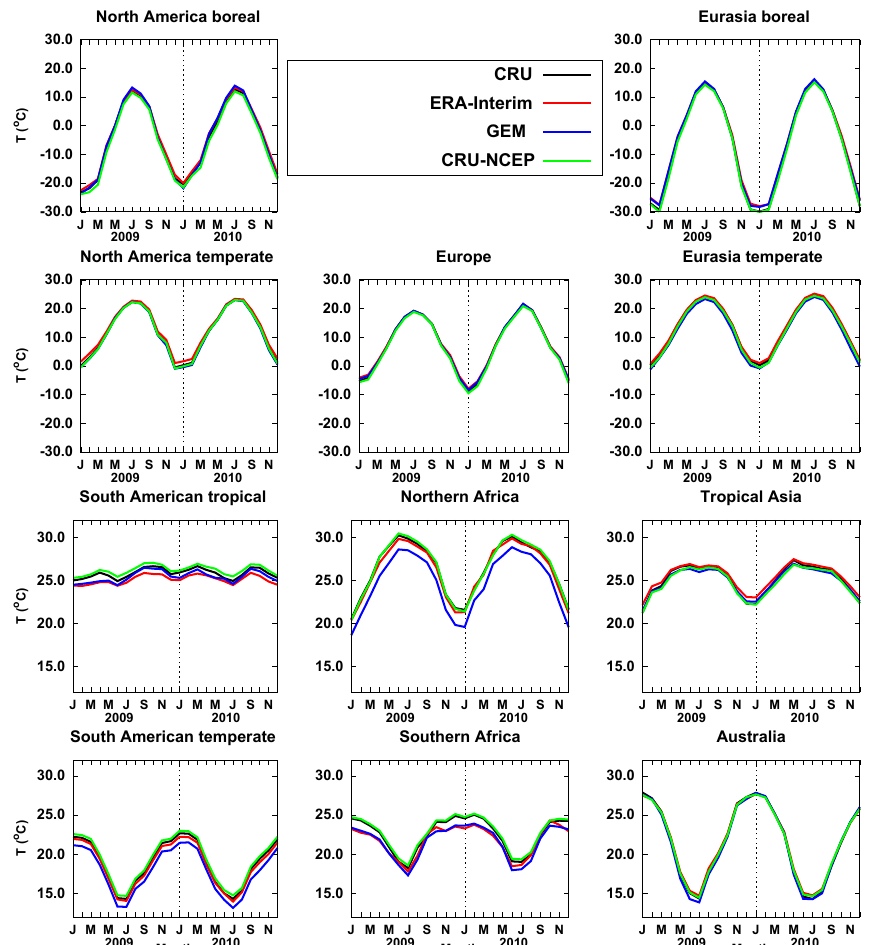
Figure 2. Monthly mean temperature ( ◦ C) averaged for the TransCom land regions.